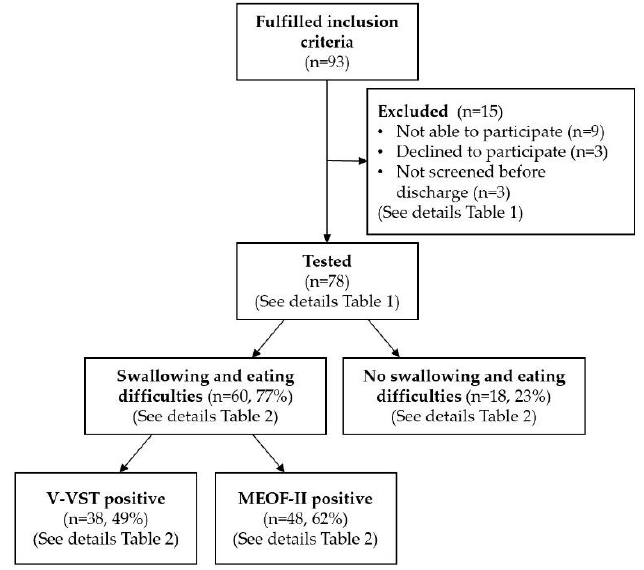
Figure 1. Flowchart describing exclusion of participants and prevalence of swallowing and eating difficulties.